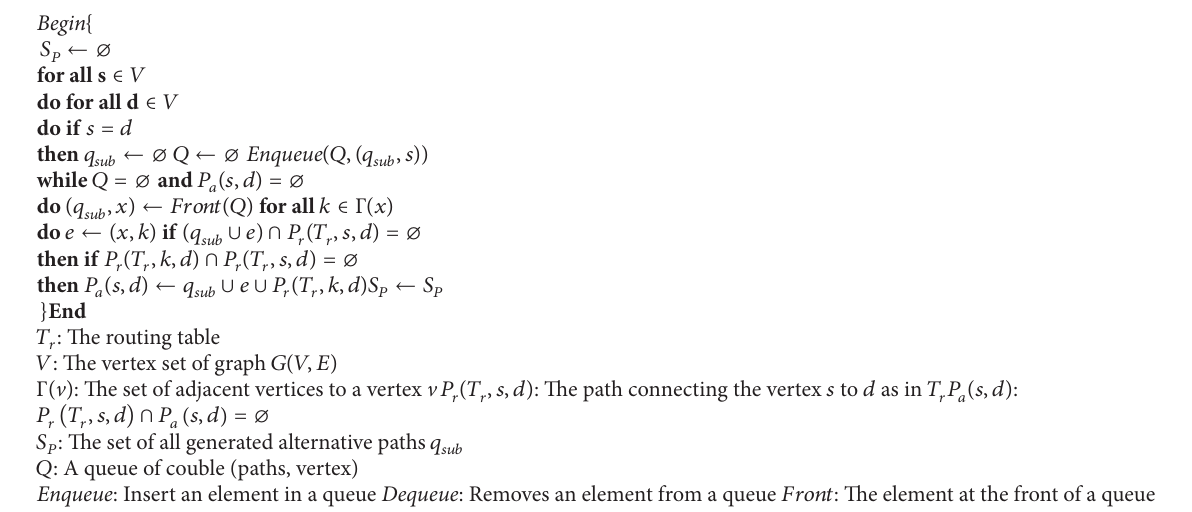
Algorithm 1: The CCA technique message